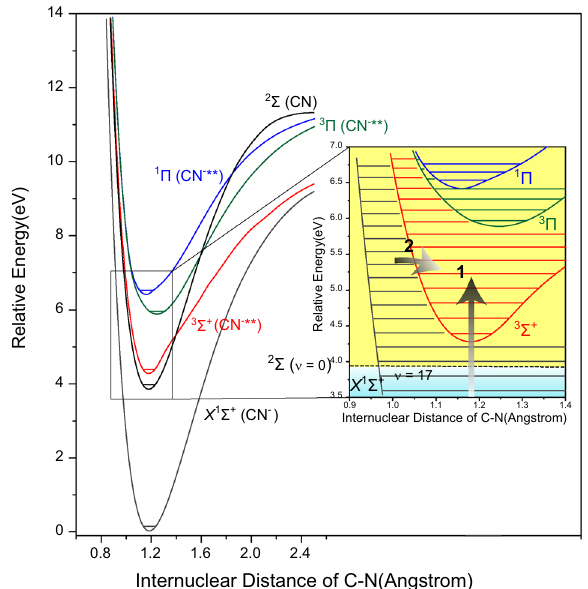
Fig. 4 Potential energy curves of CN( X 2 Σ ), CN − ( X 1 Σ + ) and CN − **( 3 Σ + , 3 Π and 1 Π ). In the inset panel, the horizontal broken line denotes the zero- point vibrational energy level of CN ( X 2 Σ ), the vibrational (horizontal parallel lines) and electronic states above these broken lines are the superexcited states and embedded on the yellow background, 1 represents the direct production of CN − ** ( 3 Σ + , 3 Π ) in the DEA process of BrCN or by electron attachment to CN( X 2 Σ ) and 2 is the intersystem transition from the high-lying vibrational states of CN − ( X 1 Σ + ) to the superexcited state 3 Σ + of CN −